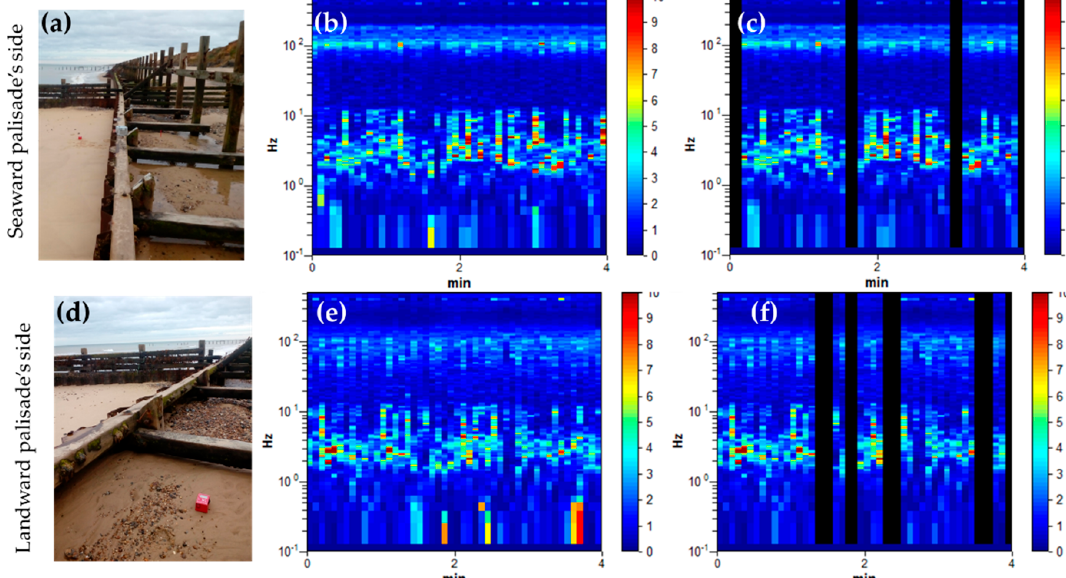
Figure 9. Noise time history recorded and used to calculate the H/V spectra at both sides of the palisade: ( a ) location of the Tromino at the seaward side of the defence; ( b ) full record measured at the seaward side; ( c ) non-used noise data at the seaward side masked with black; ( d ) location of the Tromino at the landward side of the defence; ( e ) full record measured at the landward side; ( f ) non-used noise data at the landward side masked with black;.